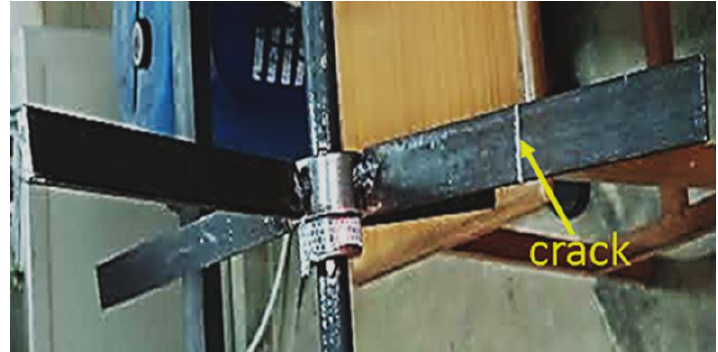
Figure 4. Cracked blade.